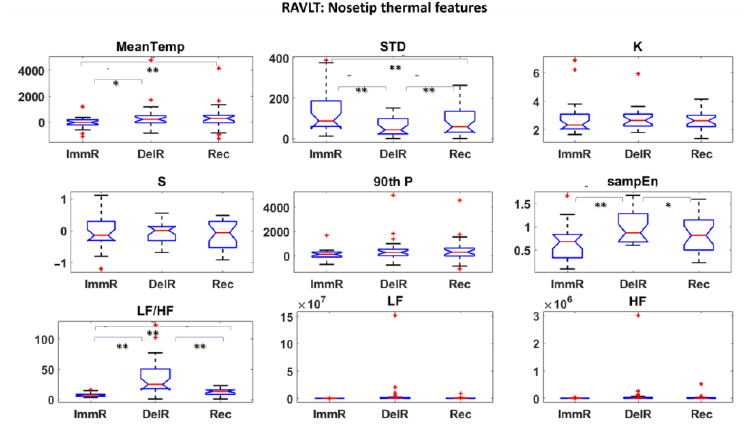
Figure 9. Thermal features relative to Nosetip ROI extracted during RAVLT (* p < 0.05; ** p < 0.01). Outliers are represented with red crosses. The titles of the single plots refer to abbreviations of features described in Section 3.3.